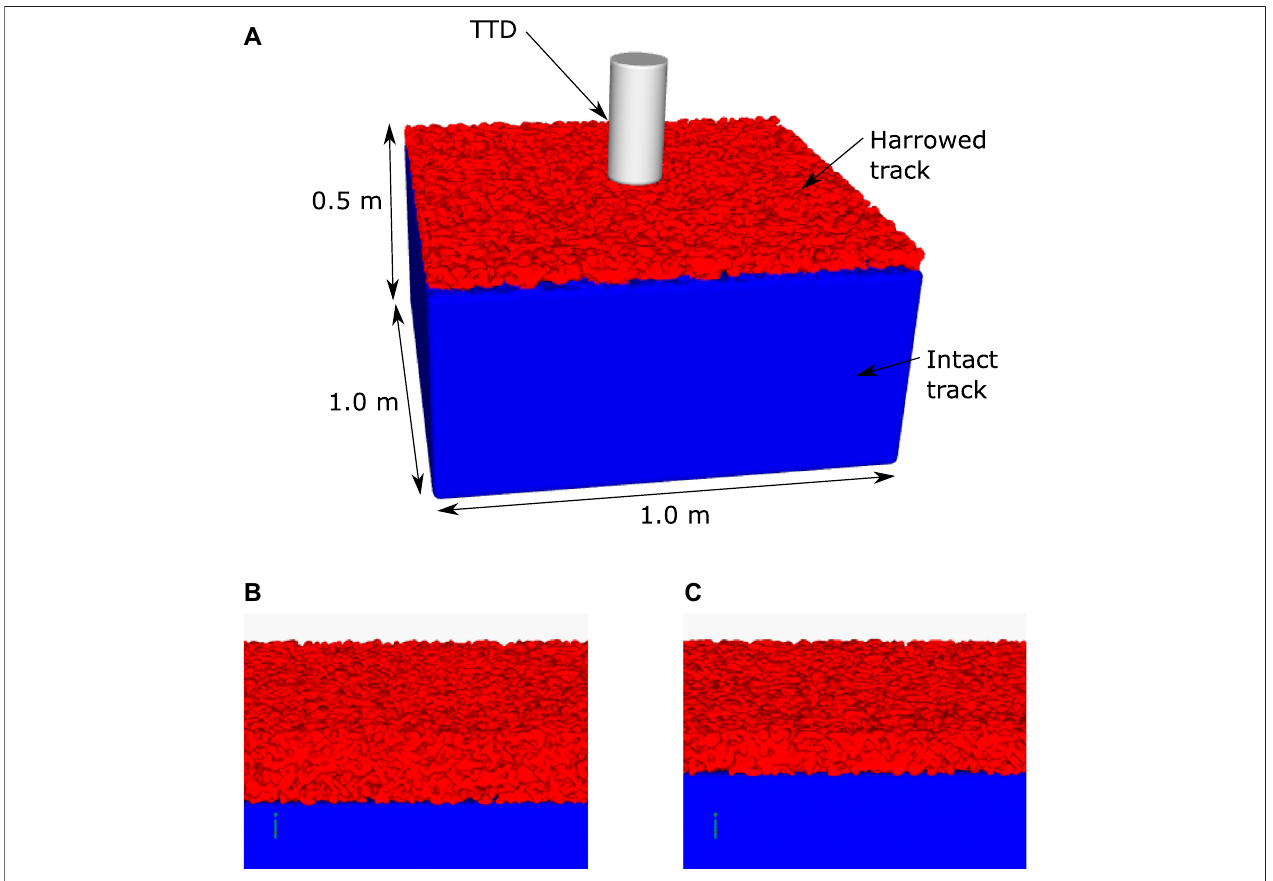
FIGURE2| Con fi gurationofthesimulationcon fi gurationforthetracktestingdevice.Thecon fi gurationforthedirttrackisshownin (A) .Thetoplayerofthetrackhas a large number of voids in the material to represent harrowing that is used to break up and soften the track surface. The track extends 0.5 m in depth, below which the ground is predominantly rock. The rock is modelled as a rigid boundary condition. The synthetic track has a depth of 0.26 m under which a rigid boundary condition is also used. Close-up views of the dirt track and synthetic track models are shown in (B) and (C) respectively, which show the non-smooth top surface created by harrowing. The track testing device (TTD) is dropped and the force and displacement are predicted by the simulation. These results are compared to the matching experimental measurements in order to calibrate the rheological component of the model for the deformation of each track surface.